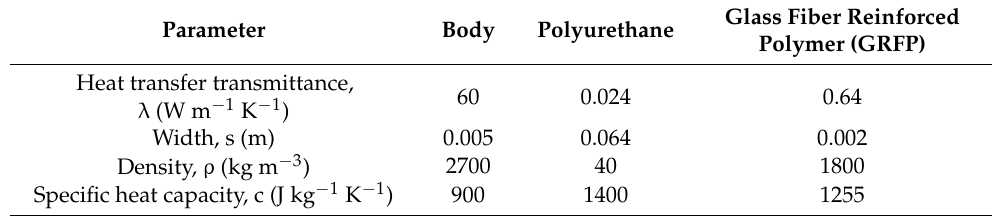
Table A2. Characteristics of different materials considered for the walls.